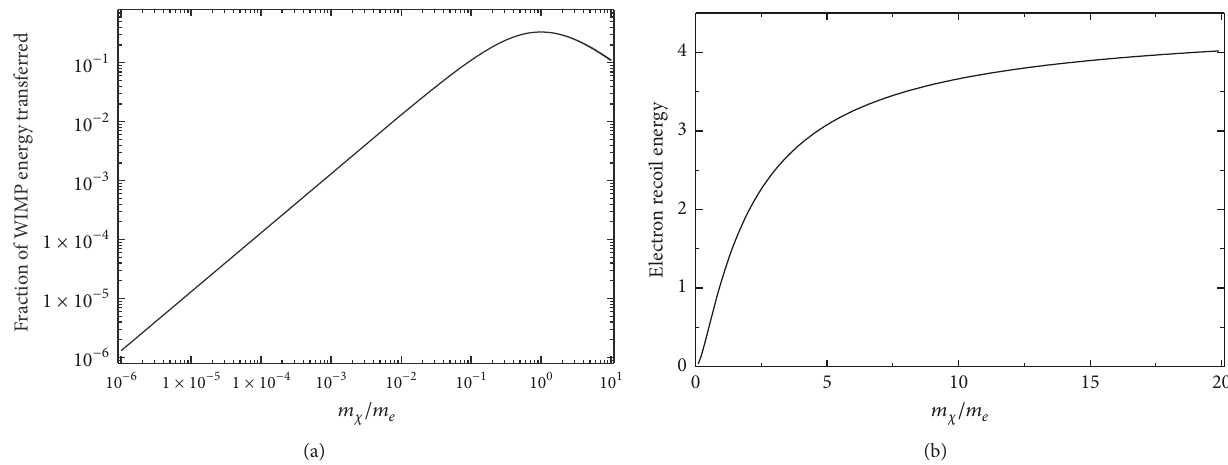
Figure 1: (a) The fraction of the energy of the WIMP that can be transferred to the electron as a function of 𝑥 = 𝑚 𝜒 /𝑚 𝑒 . (b) The electron recoil energy 𝑇 as a function of 𝑥 = 𝑚 𝜒 /𝑚 𝑒 . As 𝑥 increases it tends to 4.3 eV for 𝑦 esc = 2.84